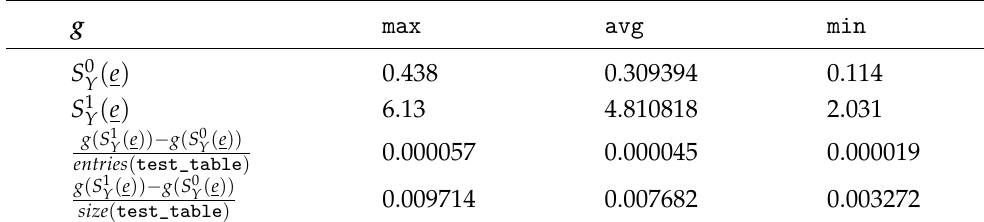
Table A1. Measurements and factors for Equation (9).